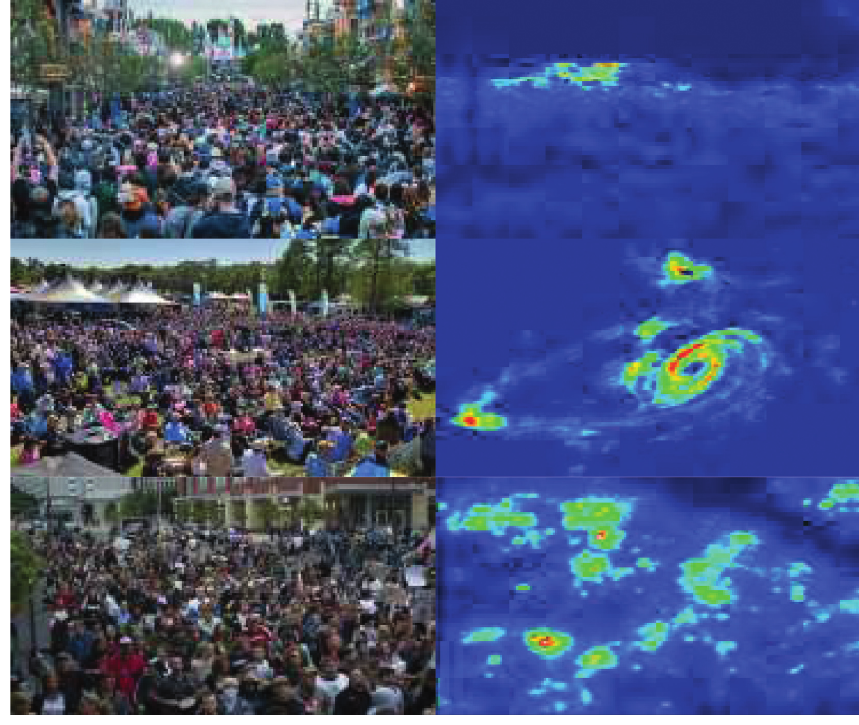
Figure 10: Visualization of the crowd density map.